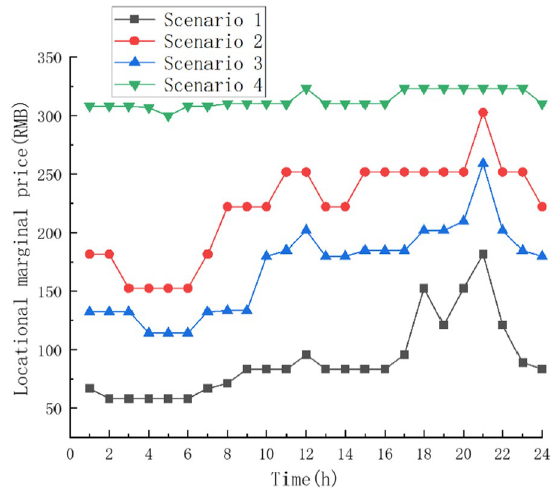
Fig. 12 Locational marginal prices obtained under the four scenarios